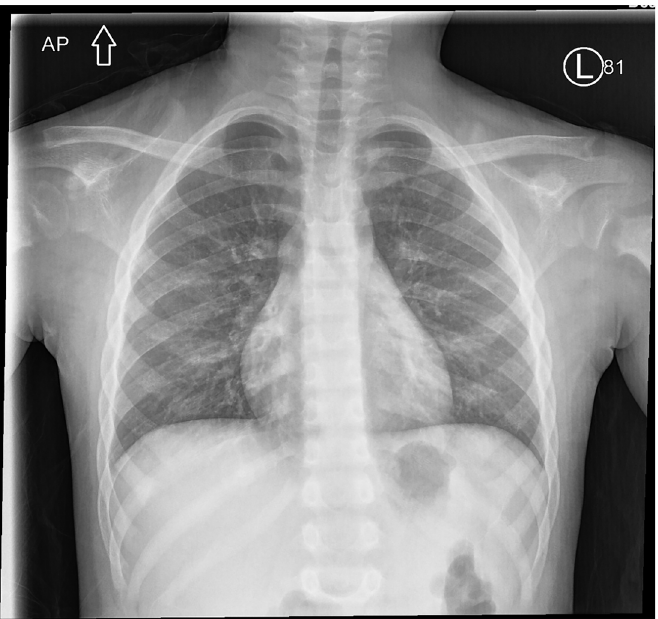
Image 2. Chest radiograph of eight-year-old boy with new- onset